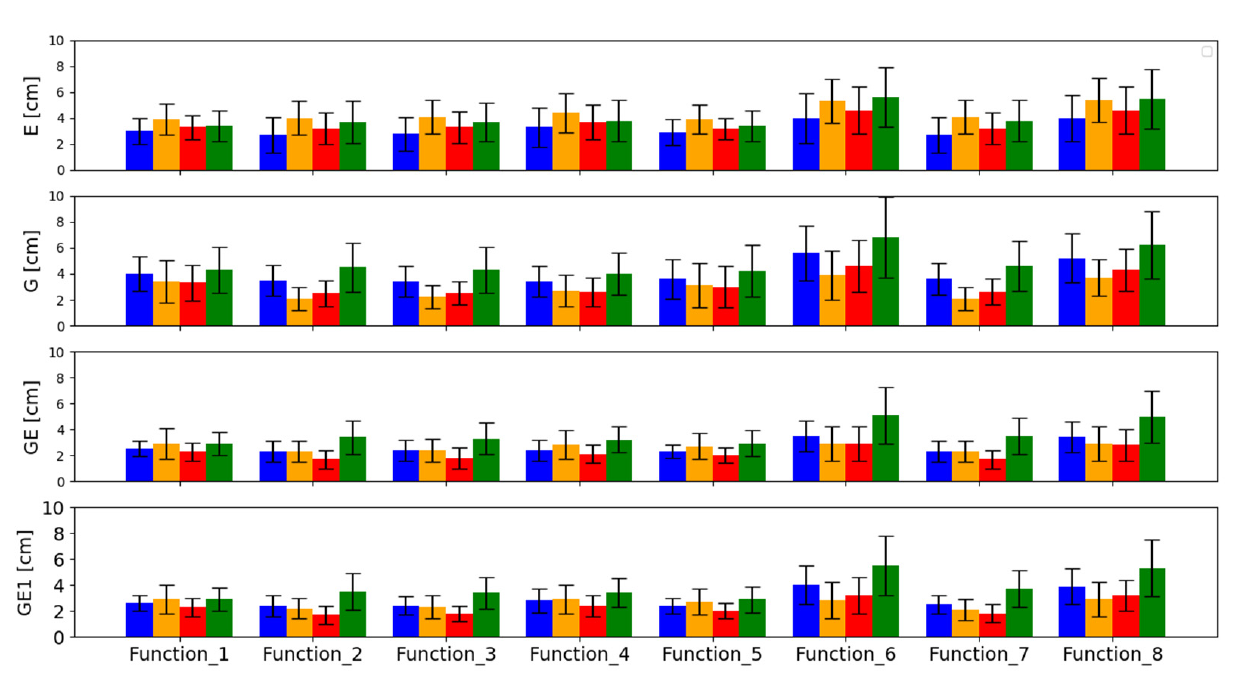
Figure A1. Analyzed the impact of different reference coordinates for obtained accuracy. Blue—weekly reference coordinates from E solution, orange—weekly reference coordinates from G solution, red— weekly reference coordinates from GE solution and green—daily reference coordinates from AC CNES/CLS. Table A1. Types of receiver and antenna mounted on stations selected for analysis, together with a list of external clocks and date of the latest changed receiver.